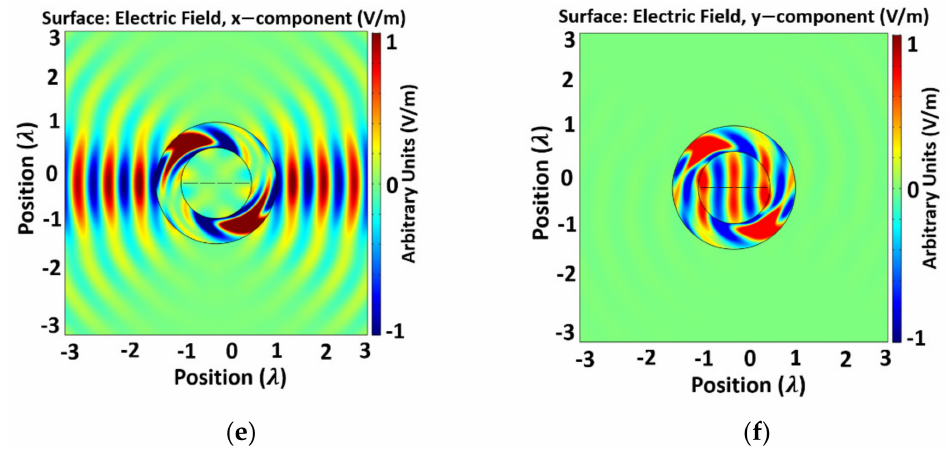
Figure 8. The electric fields of the proposed array antenna enclosed by TO-based material-embedded cylindrical beam-rotator for beam-scanning ( a ) dipole antenna array in free-scheme, ( b ) The fields of the vertical dipole array enclosed by TO-based material shell and scanned at ∅ s = 22.5 ◦ , ( c ) The fields of the vertical dipole array enclosed by TO-based material shell and scanned at ∅ s = 45 ◦ ; ( d ) dipole antenna array in free-space along the x-direction (horizontal array); ( e ) the fields of the horizontal dipole array enclosed by a TO-based material shell and that has undergone a rotation of ∅ ◦ ; ( f ) difference between the electric fields in ( a ) and ( e s = 90